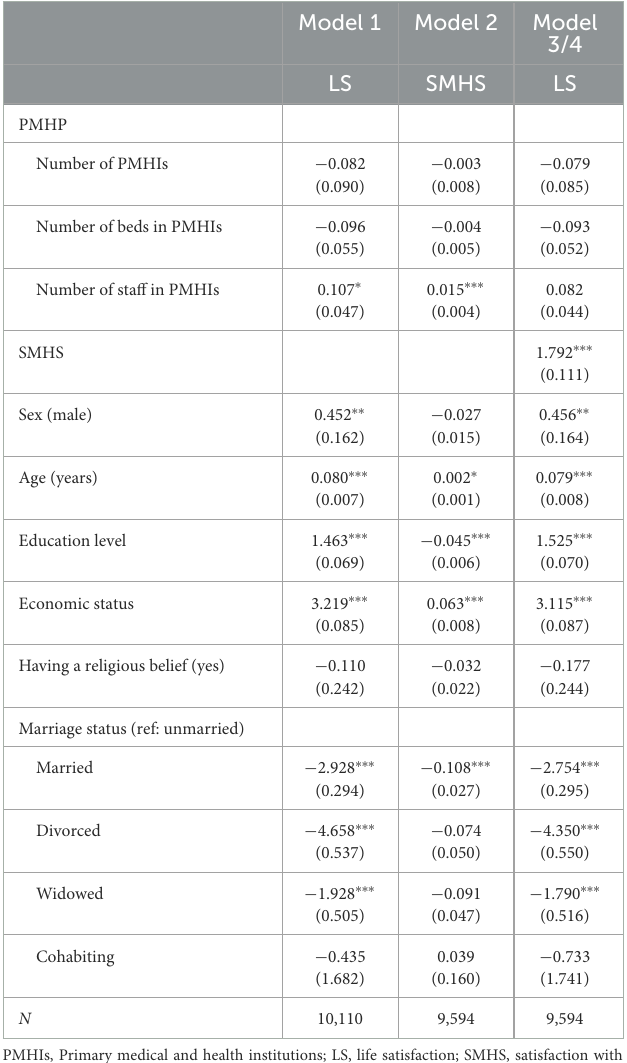
[interquartile range (IQR): (4.89, 8.647)]. The median number of TABLE 2 Associations between primary medical and health preparedness, satisfaction with medical and health service, and life